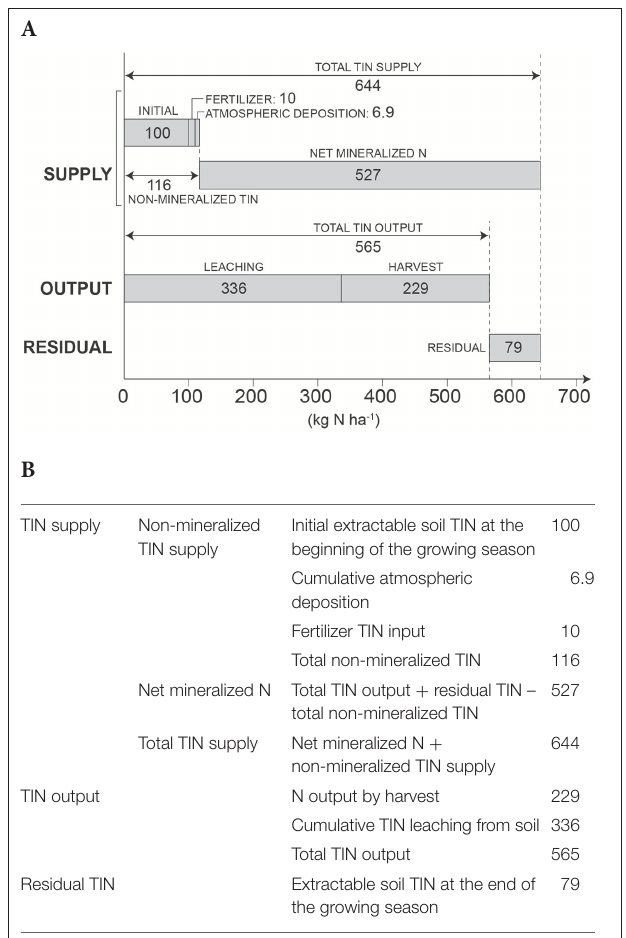
FIGURE 7 | Estimation of net mineralized N over the 2016 growing season (226 days between 3/31 and 11/12). The top figure (A) compares the N values used for the estimation. All values are expressed in terms of the area of the planting beds only. All fluxes are in kg N ha − 1 226 d − 1 , and extractable soil TIN values are in kg N ha − 1 . The bottom figure (B) summarizes N values used in the